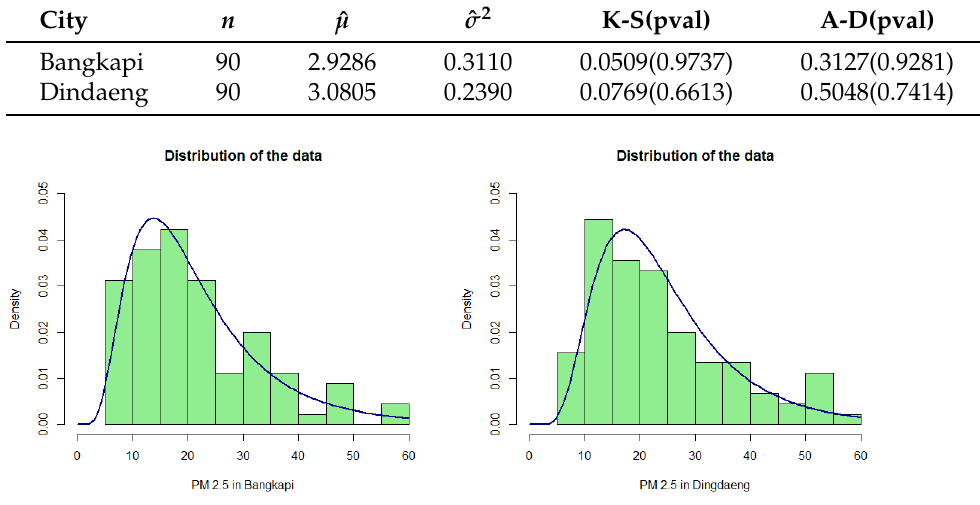
Table 6. Estimators of the log-normal distribution for the PM2.5 mass concentration data.